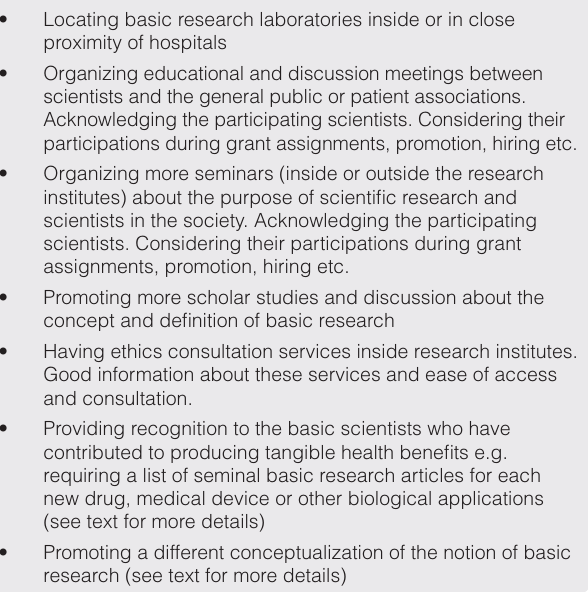
Box 1. Example of nudges (“soft” motivational incentives) potentially useful for increasing the transformative value of basic research without altering its fundamental nature or